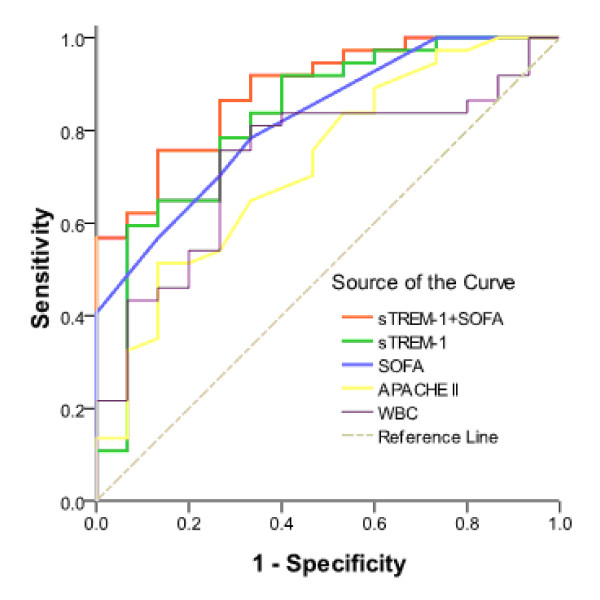
ROC curves for APACHE II scores, WBCs, SOFA scores and sTREM-1 levels for distinguishing severe sepsis from sepsis.